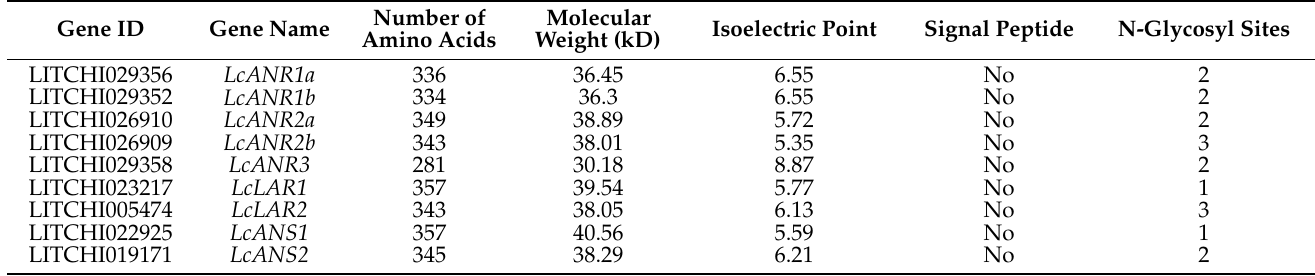
Table 1. Prediction of the biochemical characteristics of ANR, LAR, and ANS